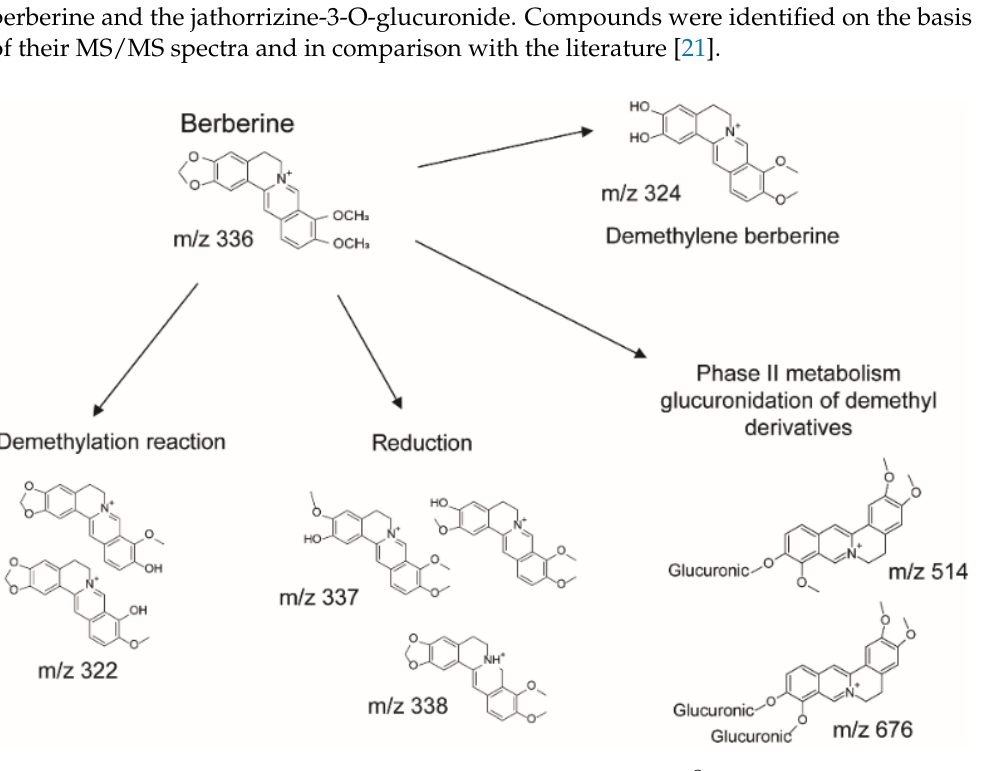
Figure 3. Metabolites detected after oral administration of Sucrosomial ® berberine.